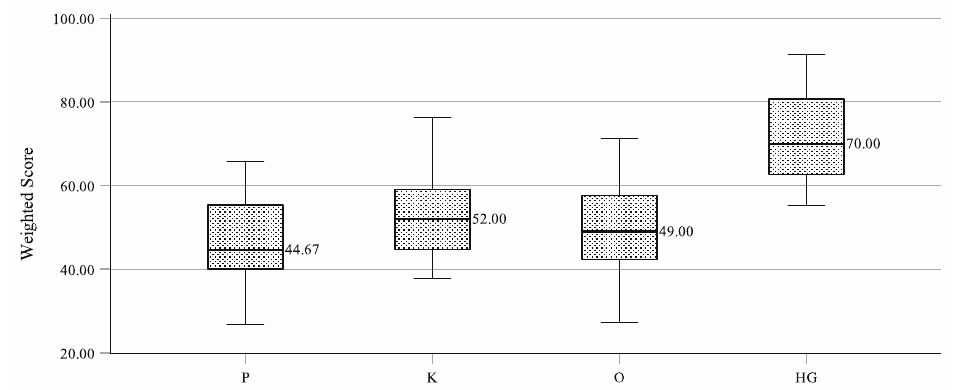
Figure 12. The distribution of the weighted score of task workload using each control method by novice group.